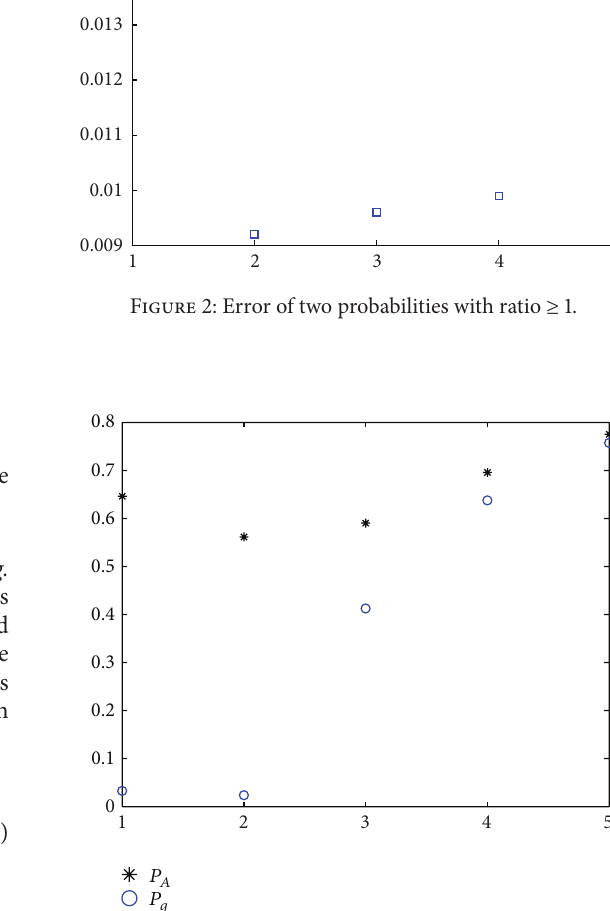
Figure 3: Comparison of two probabilities with ratio < 1.